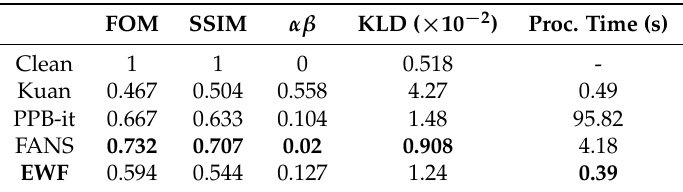
Table 2. Measures for